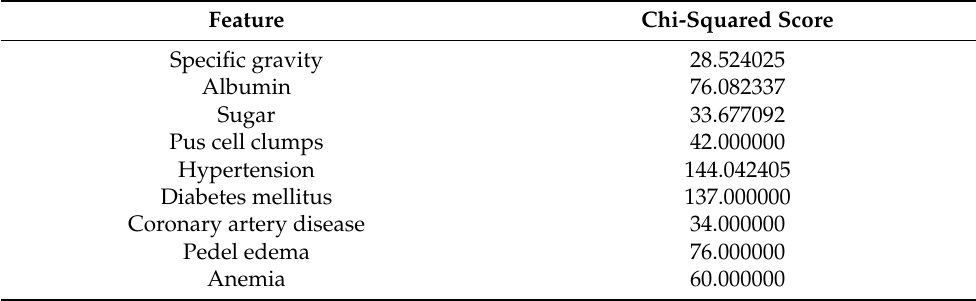
Table 2. Selected features and their chi-squared scores.